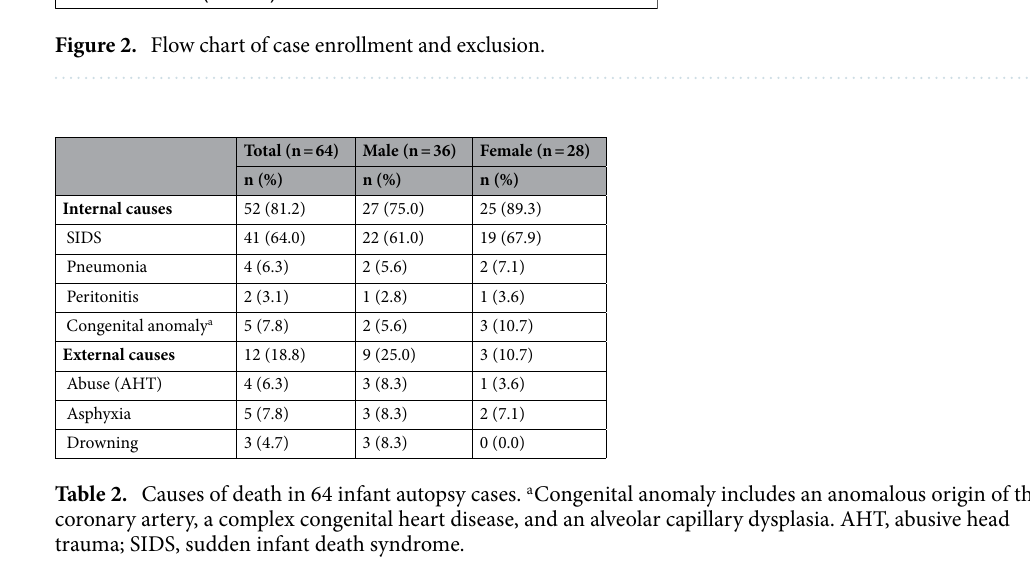
group. The risk of SIDS was lower in the 7–11 month group than in the general infant population. Supplementary Table S1 presents the results of the same calculation performed for non-breastfed male infants 0–2 month group and 3–6 month group and three-fold higher in the 7–11 month group). Almost identical values were noted for changes in SIDS incidence with and without passive smoking and co-sleeping in non-breastfed